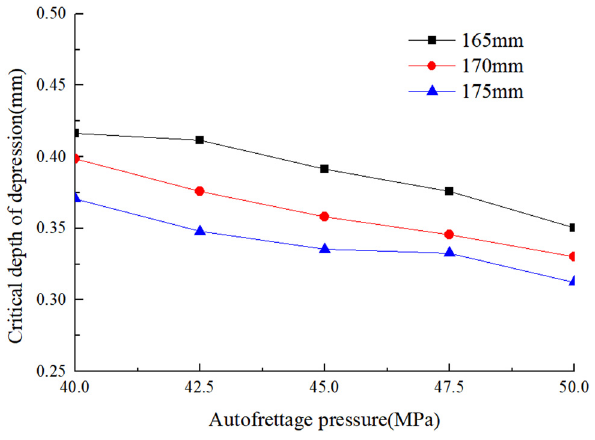
Figure 9: Relationship between the critical depth of depression and autofrettage pressure considering the variation of liner radius.